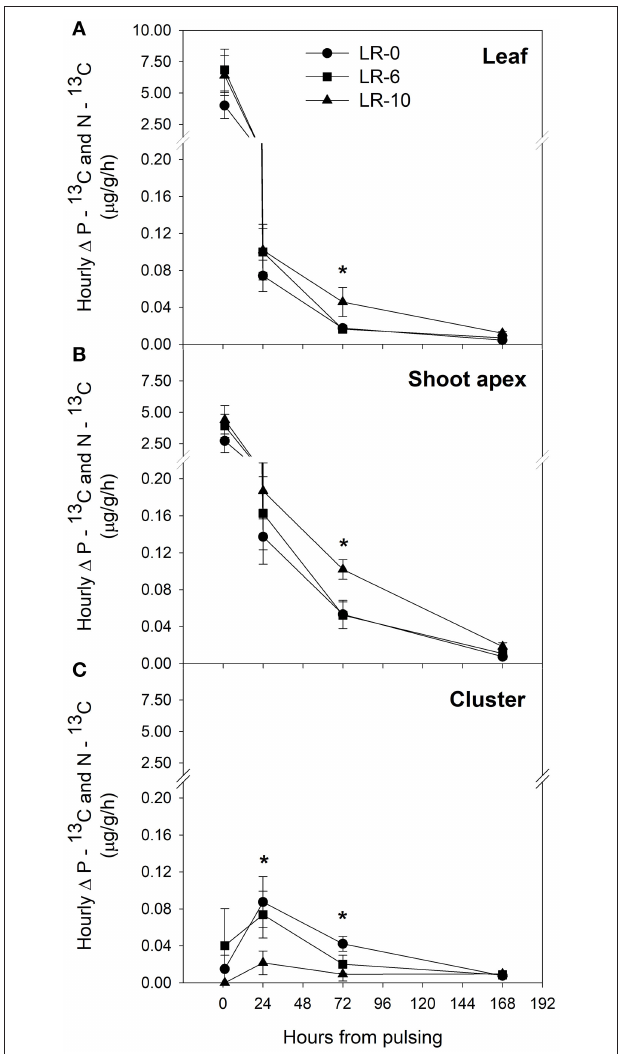
FIGURE 6 | Hourly difference ( 1 ) between the pulsed 13 C (P– 13 C) and 13 C natural abundance (N– 13 C) in leaf (A) , shoot apex (B) , and cluster (C) after 1 to 168h from 13 CO 2 pulsing in grapevines subjected to different leaf removal treatments. Each point represents the mean of 4 replicates ± SE. Zero hours from pulsing represents the moment of pulsing and correspond to 7 days after leaf removal and therefore 7 days after full bloom. Symbol (*) represent significant difference at P < 0.05.